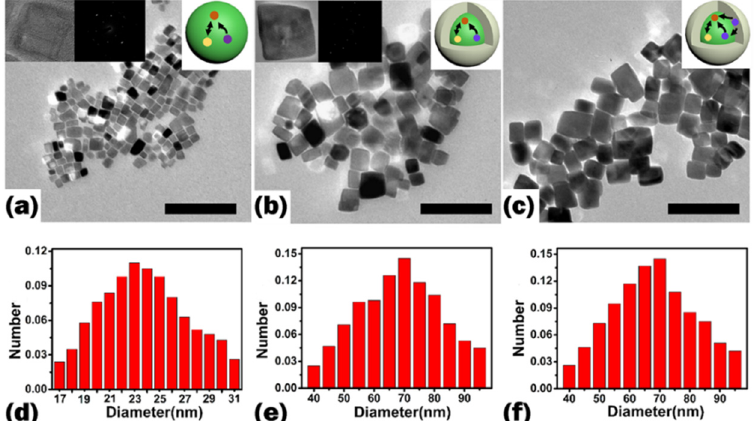
Figure 2. TEM images of XRD patterns of ( a ) KMnF 3 :18%Yb 3+ ,1%Er 3+ NPs, ( b ) KMnF 3 :18%Yb 3+ , 1%Er 3+ @ KMnF 3 NPs, ( c ) KMnF 3 :18%Yb 3+ ,1%Er 3+ @ KMnF 3 :2%Yb 3+ NPs (the inset shows a schematic illustration of corresponding NPs). Histograms of ( d ) KMnF 3 :18%Yb 3+ ,1%Er 3+ NPs, ( e ) KMnF 3 :18%Yb 3+ ,1%Er 3+ @ KMnF 3 NPs, and ( f ) KMnF 3 :18%Yb 3+ ,1%Er 3+ @KMnF 3 :2%Yb 3+ NPs size